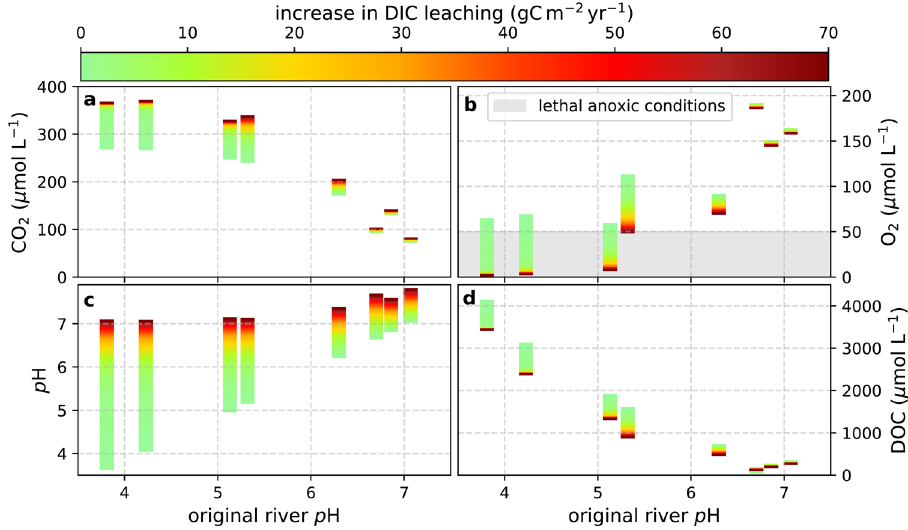
Fig. 2 Impact of enhanced weathering on river properties. Impact of enhanced DIC leaching on a CO 2 concentrations, b O 2 concentrations, c water pH, and d DOC concentrations in Southeast Asian rivers versus the original water pH. Colors indicate the response of parameters to enhancement in DIC leaching as e.g. caused by EW.